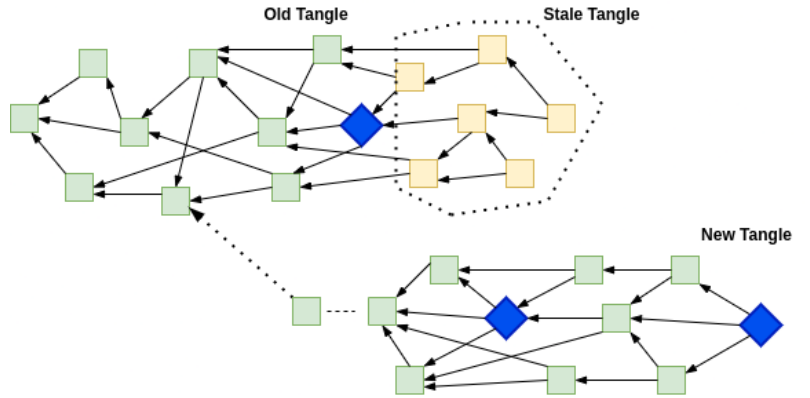
Figure 9. Logical representation of Tangle split.